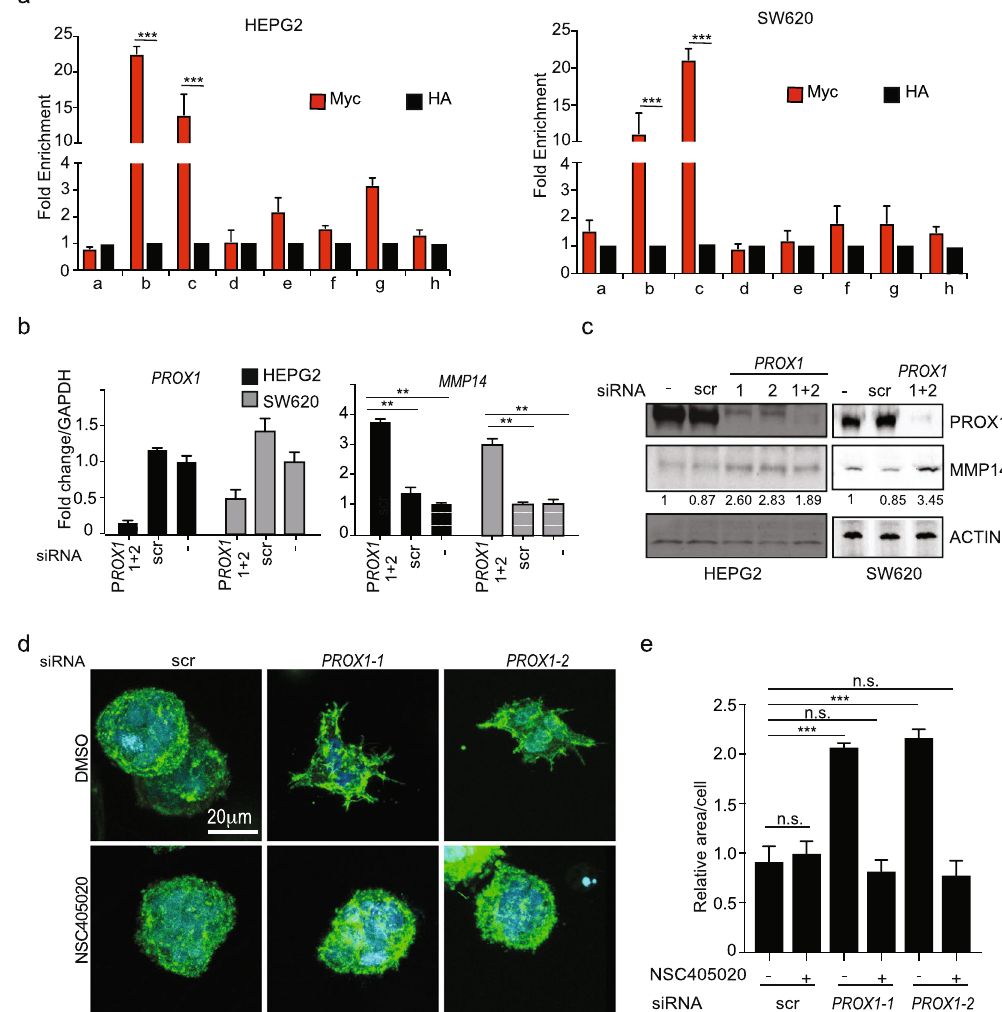
Figure 4. PROX1 silencing increases MMP14 expression and MMP14-dependent 3D sprouting in cancer cells. ( a ) Chromatin immunoprecipitation in HepG2 and SW620 cells ectopically expressing Myg-tagged PROX1. Chromatin was immunoprecipitated using either an anti-Myc antibody or an irrelevant anti-HA antibody and subsequently amplified by qPCR for the indicated regions of the MMP14 promoter (illustrated in Fig. 2b). Average fold enrichment over the anti-HA control is shown for three independent experiments; error bars represent SD. ( b ) HepG2 and SW620 cells were transfected with the indicated siRNAs for 48 h and whole cell extracts were analysed by RTqPCR for the indicated targets with GAPDH as an internal control. Bars represent an average of two independent experiments, error bars show SD across the experiments. ( c ) HepG2 and SW620 cells were treated as in ( b ) and whole cell extract was analysed by immunoblot for the indicated proteins using actin as a loading control; numbers indicate the intensity of the MMP14 band normalized to the corresponding loading control. Cropped membranes are shown, uncropped membranes can be found in Fig. S3c,d. ( d , e ) 3D fibrin invasion assay with HepG2 cells transfected twice in consecutive days with the indicated siRNAs and embedded in 3D fibrin in the presence of either DMSO or 50 μ M of the MMP14 inhibitor NSC405020. After 4 days, fibrin gels were fixed and stained with Phalloidin (Phall A488) and Hoechst 33342. ( d ) Representative images are shown. ( e ) Quantification of three images per condition from two independent experiments (n > 100 cells/condition). Bars represent the average area occupied by each cell cluster and normalized to the scr siRNA and DMSO-treated sample. n.s.: non-significant; ** p > 0.01; *** p >